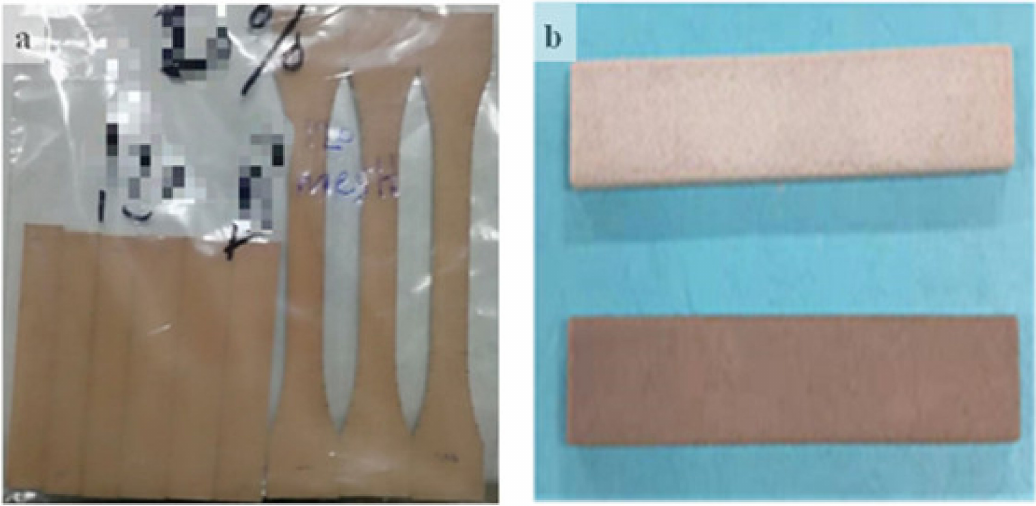
Figure 9. Selective laser sintering (SLS) samples for ( a ) the tensile and bending tests, and ( b ) the waxing